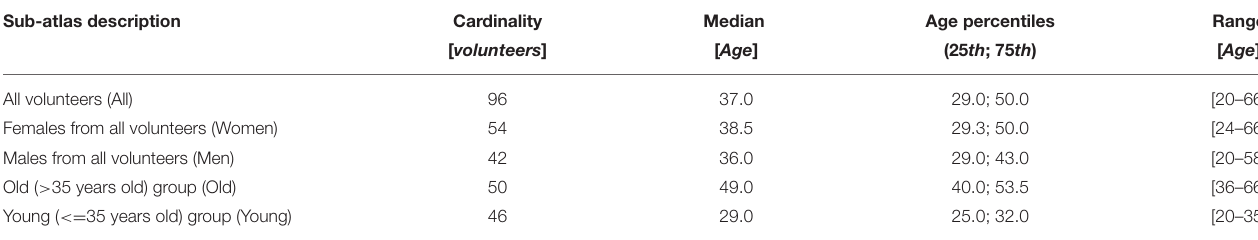
TABLE 1 | Subpopulation templates names, description, and cardinality. Sub-atlas